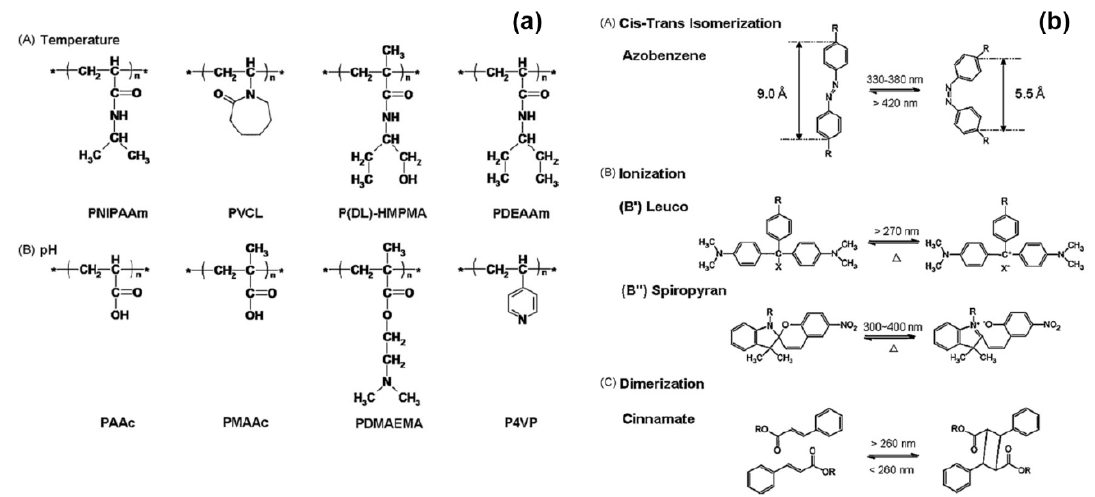
Figure 8. ( a ) Examples of molecular structures responsive to temperature (A) and pH (B). ( b ) Examples of molecular structures of photo-responsive monomers: cis–trans isomer of azobenzene (A); ionization monomers (B) of leucos (B’) and spiropyran (B”); and dimerization monomer of cinnamate (C). (III) Orientation changes (A) and molecular structures (B) of liquid crystalline molecules (reprinted with permission from [124], Copyright 2010, Elsevier).